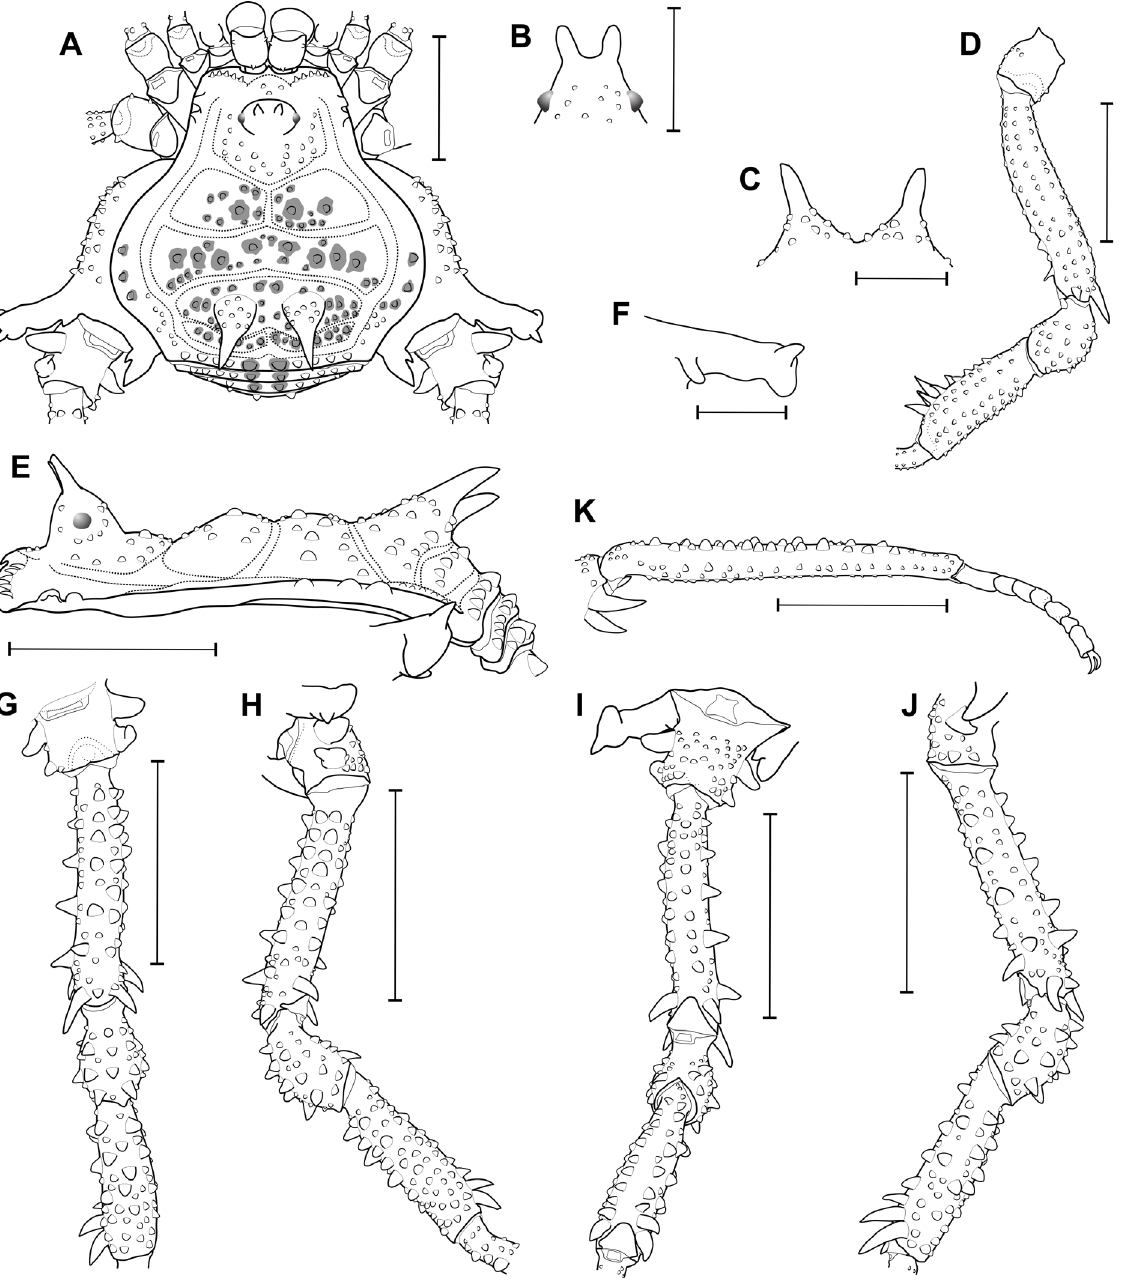
Fig. 12. Lacronia nigra (B. Soares, 1942) comb. nov., ♂ (MNRJ 60385). A . Habitus, dorsal view. B . Ocularium, frontal view. C . Armature of mesotergum area III, posterior view. D . Fe–Ti III, prodorsal view. E . Habitus, lateral view. F . Detail of the Cx IV prodorsal distal apophysis, posterior view. G . Right Fe–Ti IV, dorsal view. H . Same, prolateral view. I . Same, ventral view. J . Same, retro-lateral view. K . Right Mt–Ta IV, retro-lateral view. Scale bars: A, D–E, K = 2 mm; B–C, F = 1 mm; G–J = 3